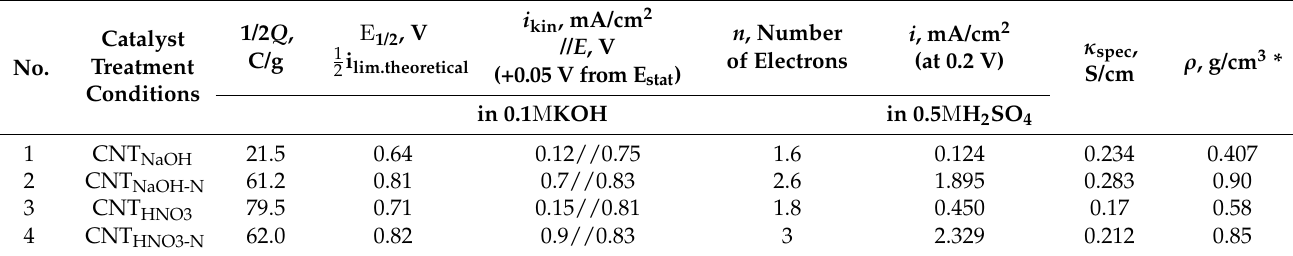
Table 2. Electrical conductivity and electrochemical characteristics of modified CNT.